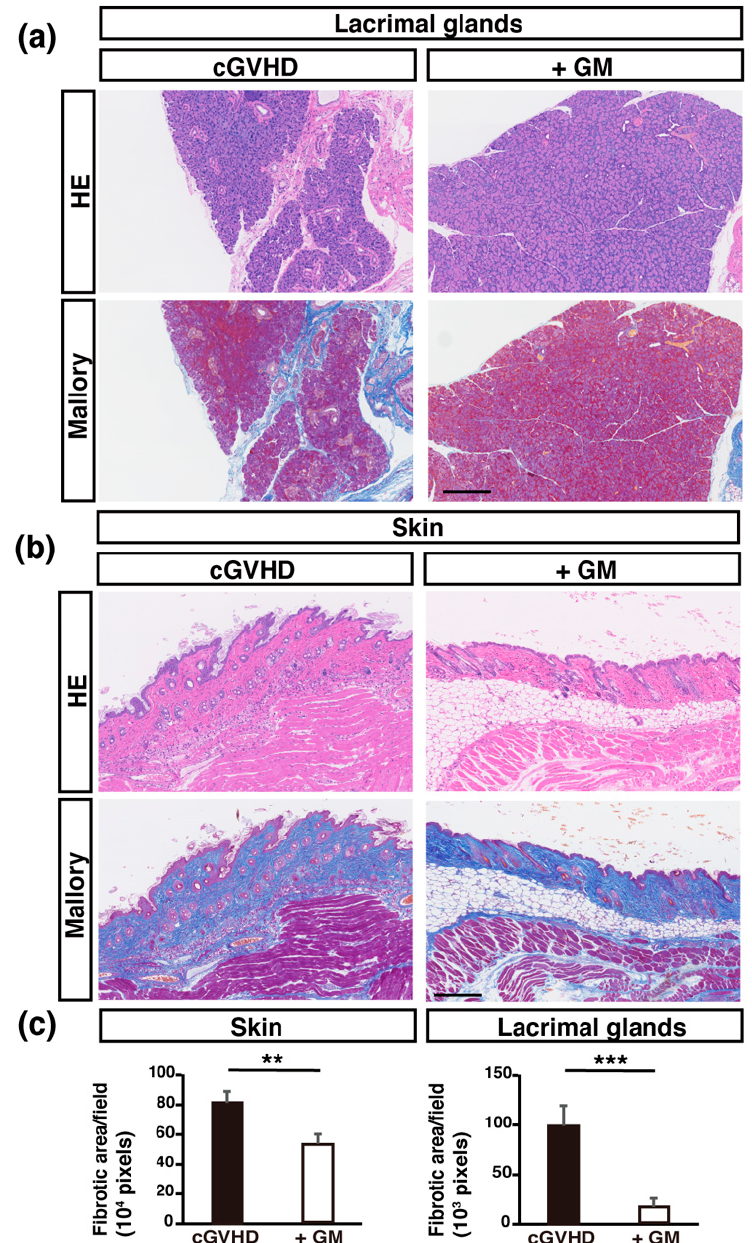
Figure 2. Pathological findings and analysis: ( a , b ) H&E and Mallory staining of lacrimal glands (LGs) and skin and from non-treated cGVHD mice (left) and gentamicin-treated cGVHD mice (+GM) (right); ( c ) Blue fibrotic areas indicated by Mallory staining were measured using ImageJ ( n = 5 per group; 3 fields). Data are presented as mean ± SEM. ** p <0.01, *** p <0.001, unpaired Student’s t -test. Scale bar, 250 μ m.